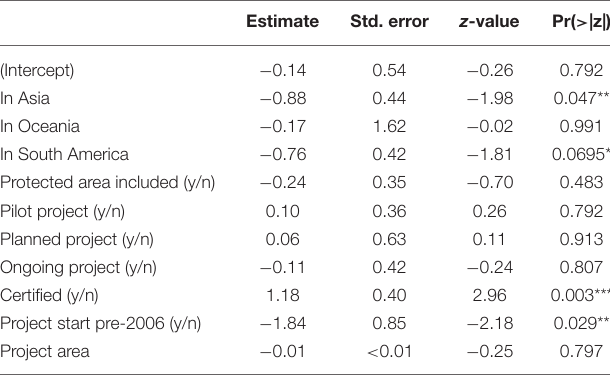
TABLE 2 | To pay or not to pay conditionally: REDD project plans for local implementation. Estimate Std.